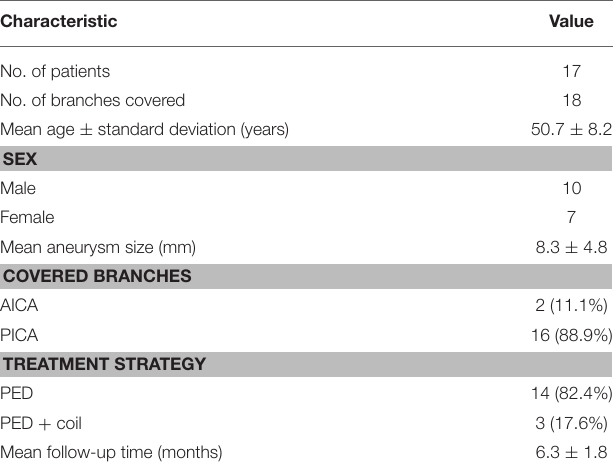
TABLE 1 | Demographics and clinical